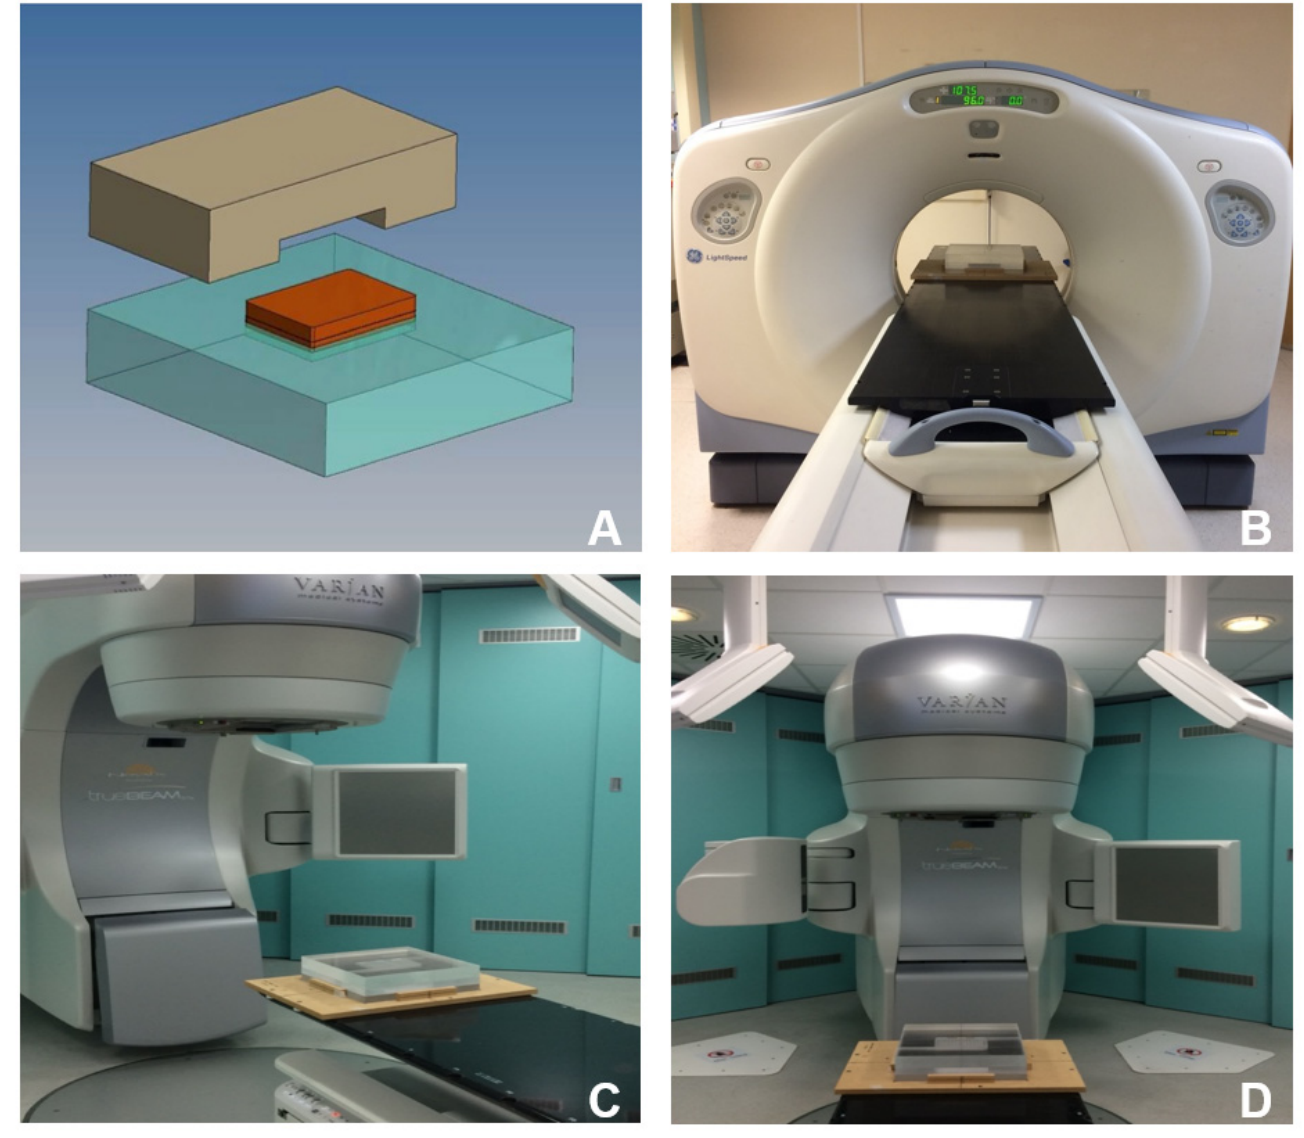
Figure 1. ( A ) Design of multiwell tissue culture plate holding device. The top plate (stone colour) has two halves to facilitate the handling of plates for accurate positioning. The bottom plate is shown in light green and a representative tissue culture plate is shown in red. ( B ) Multiwell tissue culture plate scanning in a computed tomography scanner. ( C,D ) Multiwell tissue culture plate irradiation in a clinical linear accelerator. Plates positioned within multiwell tissue culture plate holding device, with the use of room lasers for accurate reproducibility. Plate holder attached to the CT scanner and linear accelerator by a medium-density fibreboard plate (brown).